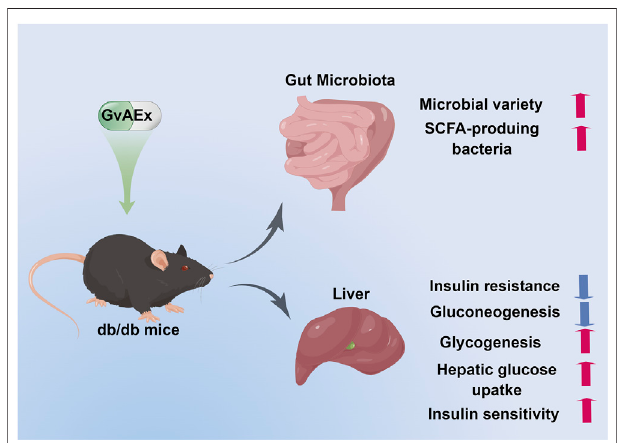
FIGURE 6 | Proposed working model of GvAEx induced anti-diabetic effect in db/db